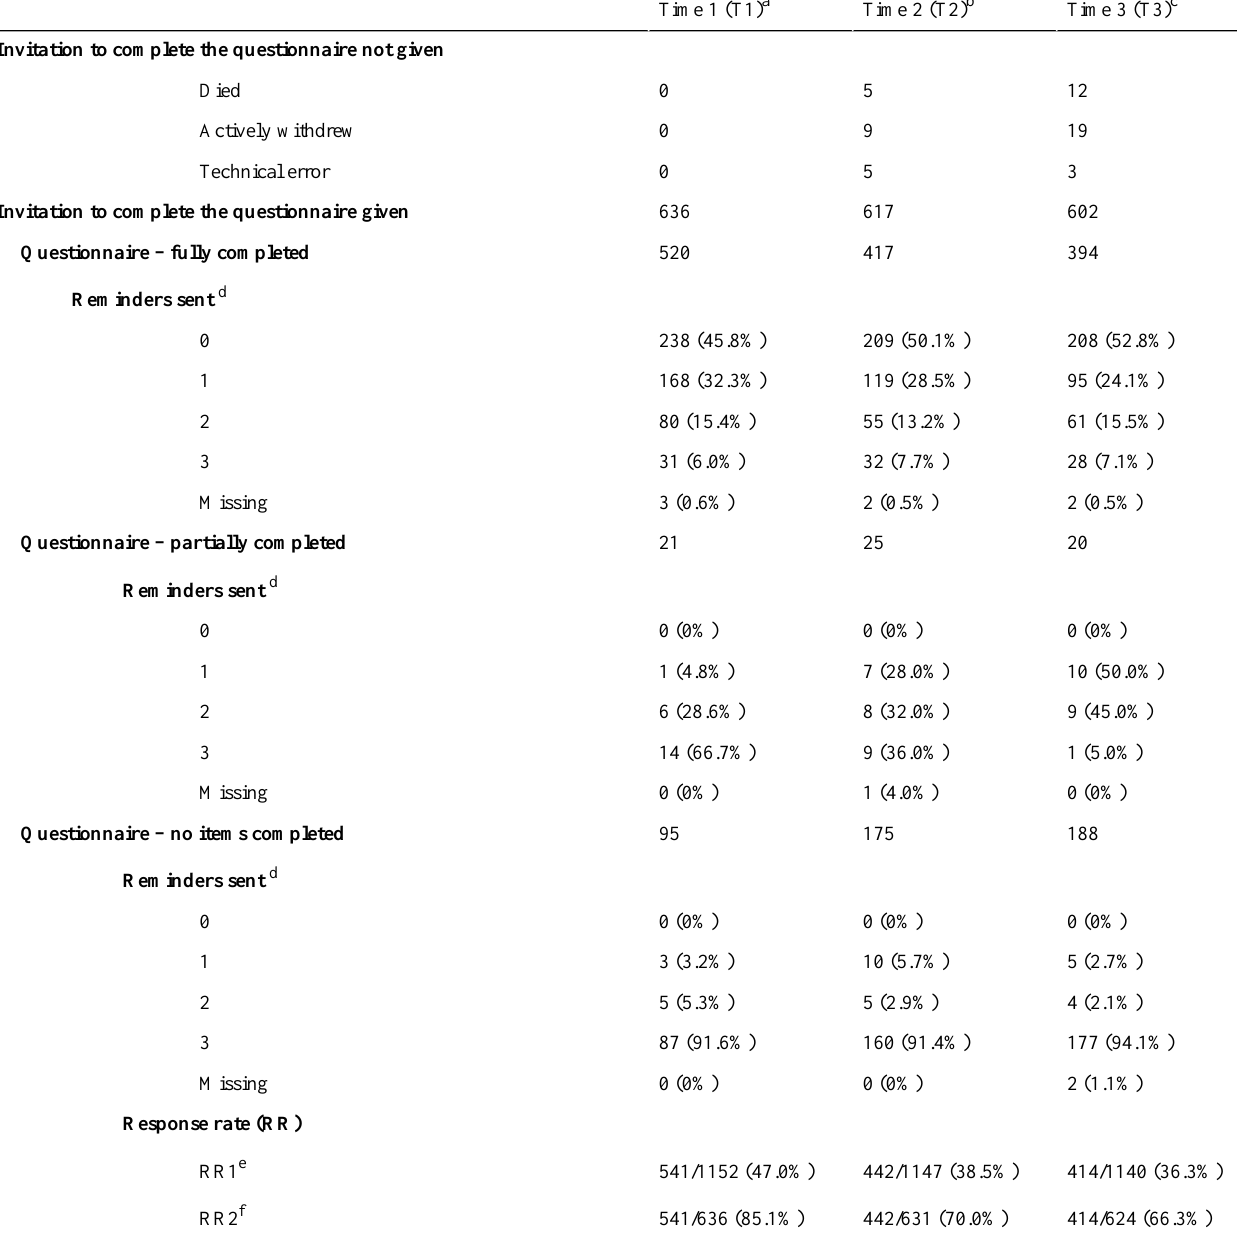
Table 2. Questionnaire completion, reminders sent, and response rates at all time-points (number of items in questionnaire [number varies dependent upon diagnostic group] T1=80, T2=102-108,